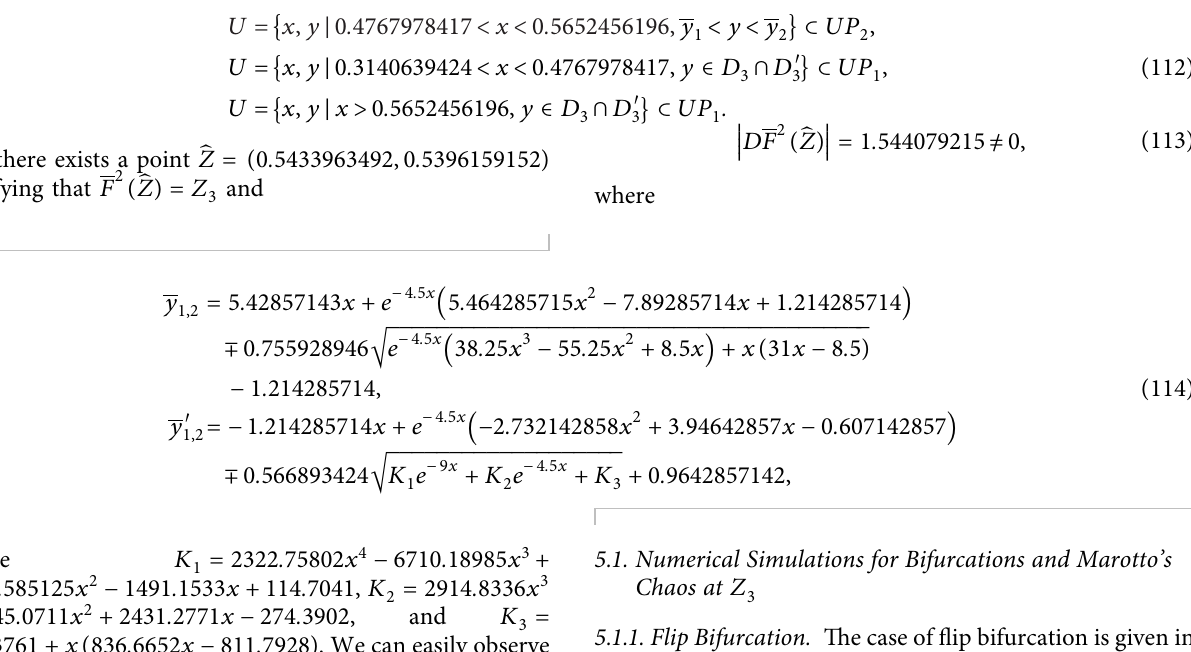
Figure 3. Suppose that parameters 0 . 1 ≤ a ≤ 1 . 1, r � 2 . 9 and ε � 4 . 5, based on Teorem 1, we know model (4) has only one positive fxed point Z . Figure 3(a) shows the bi- 3 furcation diagram of the model with respect to the bi- furcating parameter a in ( a, x ) plane with initial values (0.9, 0.9), the fip bifurcation (labeled “FB”) takes place � ( 0 . 8036104706 , 0 . 8036104706 ) for the fxed point Z 3 � 1 . 664046302 and with a � 0 . 6896609431 , α 1 � 2 . 266430550 > 0. Te chaotic attractor for a � 0 . 2 is α 2 given in Figure 3(b) and the corresponding time sequence diagram is given in Figure 3(c) which shows the chaotic nature. Figure 3 confrms the correctness of the theo- retical results in Teorem 5.